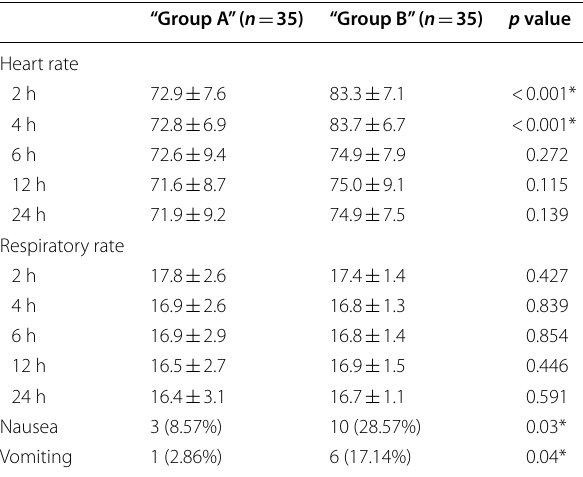
Table 3 Comparisons between the two groups regarding heart rate, respiratory rate, nausea, and